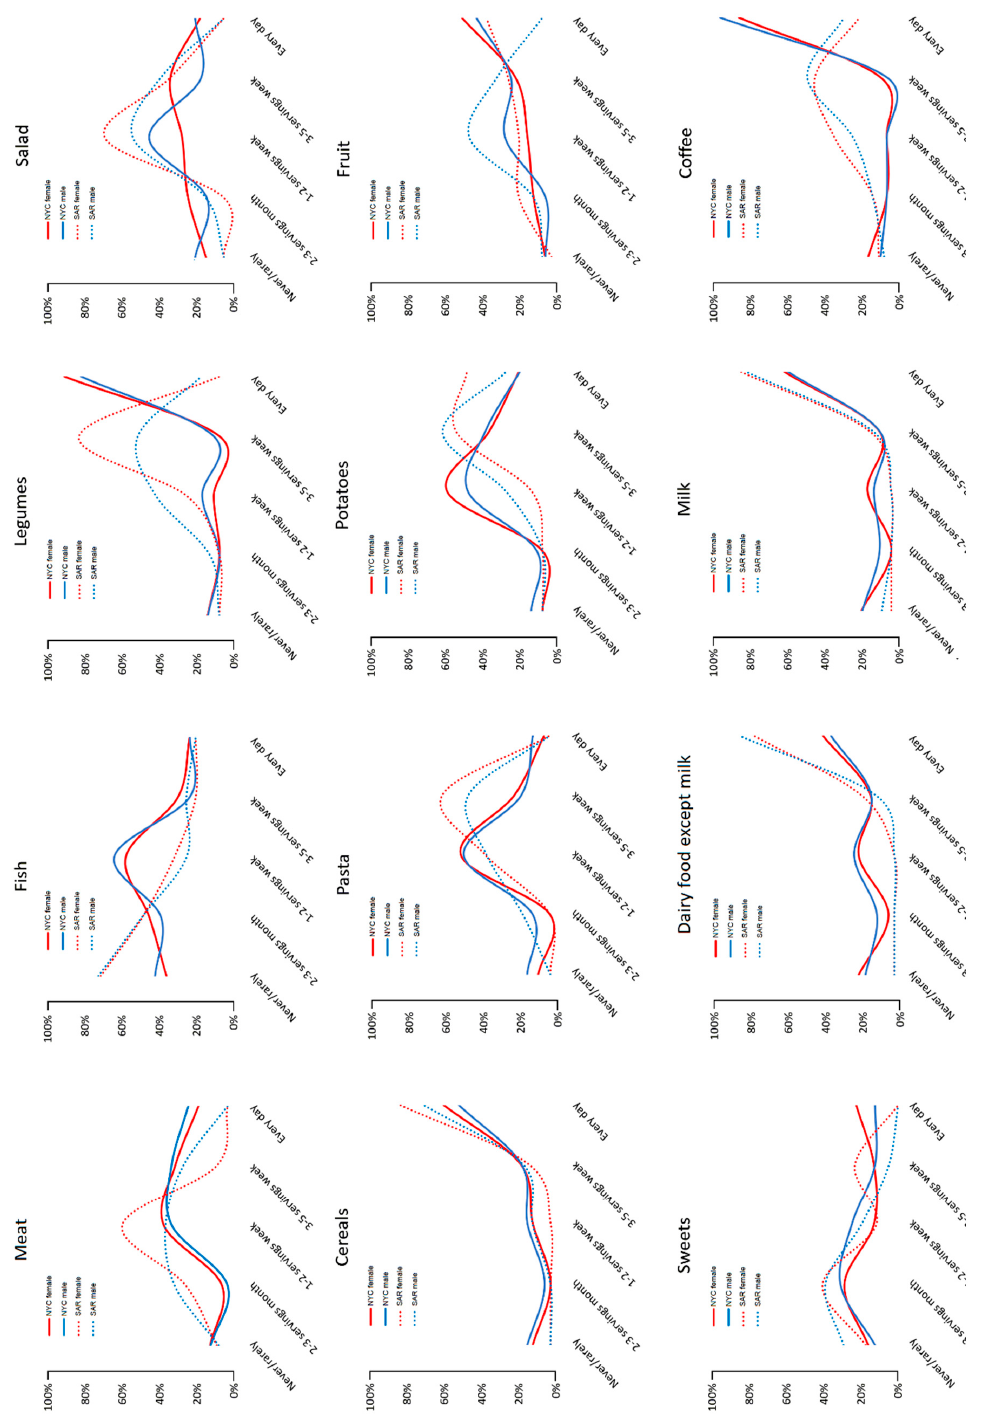
Figure 1. Frequency of consumption of common foods in participants from Nicoya (continuous lines) and Ogliastra (dotted lines), with male (blue lines) and female (red lines) highlighted.